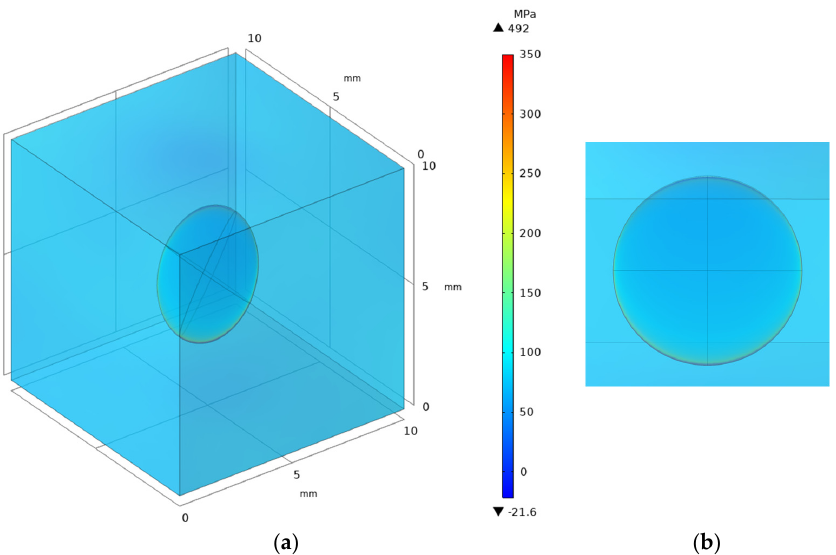
Figure 12. ( a ) Simulation strain diagram of ellipsoidal fracture, ( b ) the detailed diagram shows the stress at the fracture.